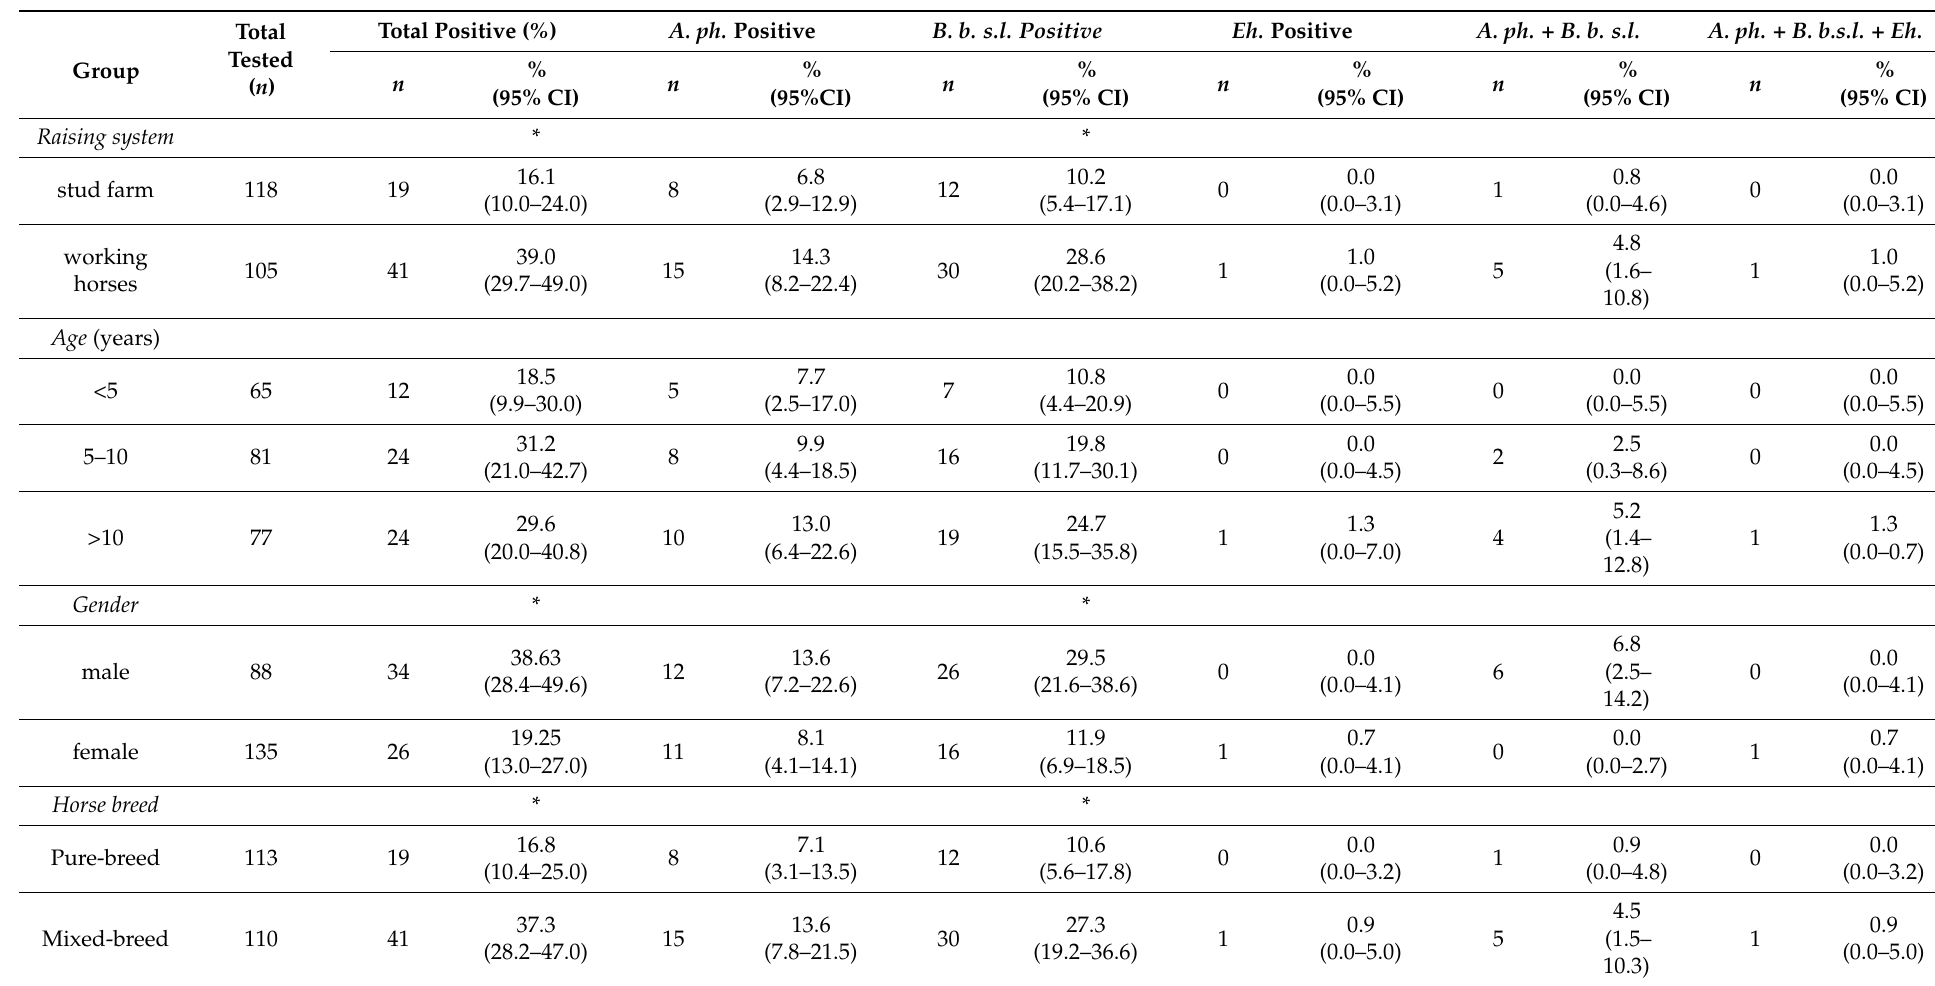
Table 2. Seroprevalence of Anaplasma phagocytophilum ( A. ph. ) , Borrelia burgdorferi senso lato ( B. b. s.l. ), and Ehrlichia spp. ( Eh. ) in horse populations, Romania (stratified by raising system, age, gender, breed, and